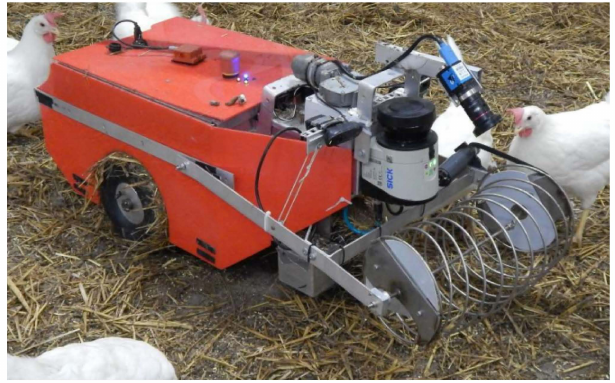
Figure 22. PoultryBot among hens in the test environment [112].